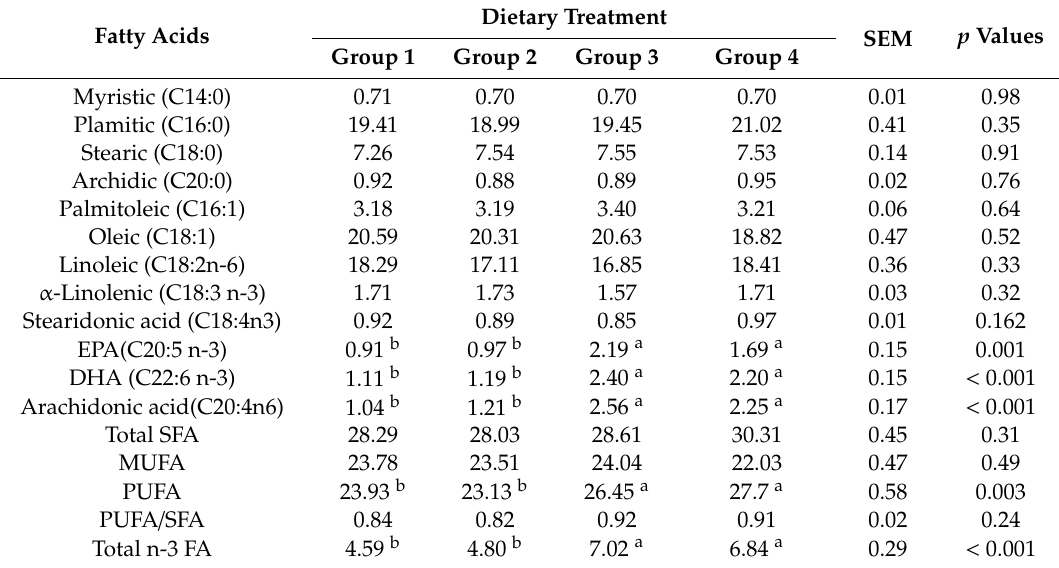
Table 5. Profiles of fatty acids in breast muscle of broilers chickens fed di ff erent species of microalgae for 32